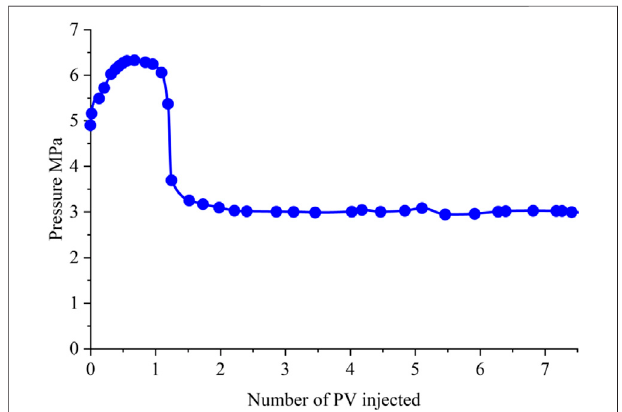
FIGURE 5 | The pressure change of the phantom